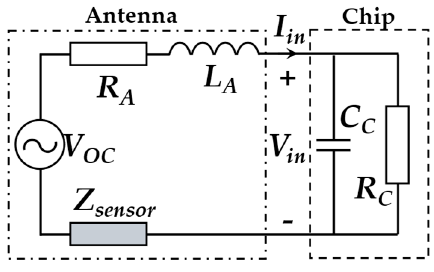
Figure 4. The equivalent circuit of UHF RFID